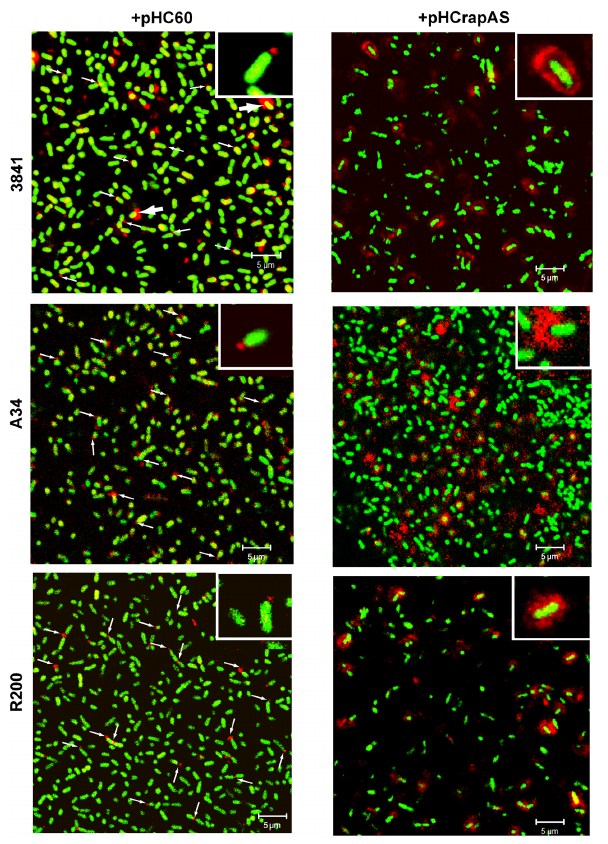
FIGURE 5 | RapA localization under endogenous and overexpressing conditions. Immunofluorescence (IF) images acquired by CLSM of GFP-labeled strains (green) harboring pHC60 or pHCrapAS using anti-RapA2 antiserum and a Cy3-labeled secondary antibody (red) are shown. Thin arrows indicate polar localization of RapA. Thick arrows indicate capsule-like localization of RapA in the 3841 wild type strain. Details of polar (left) and capsule-like localization (right) are shown in the insets. Representative unbiased CSLM images of four different experiments using a Plan-Apochromat 100x/1.4 Oil Objective were acquired in a Carl Zeiss PASCAL LSM 5. White bar: 5 µ